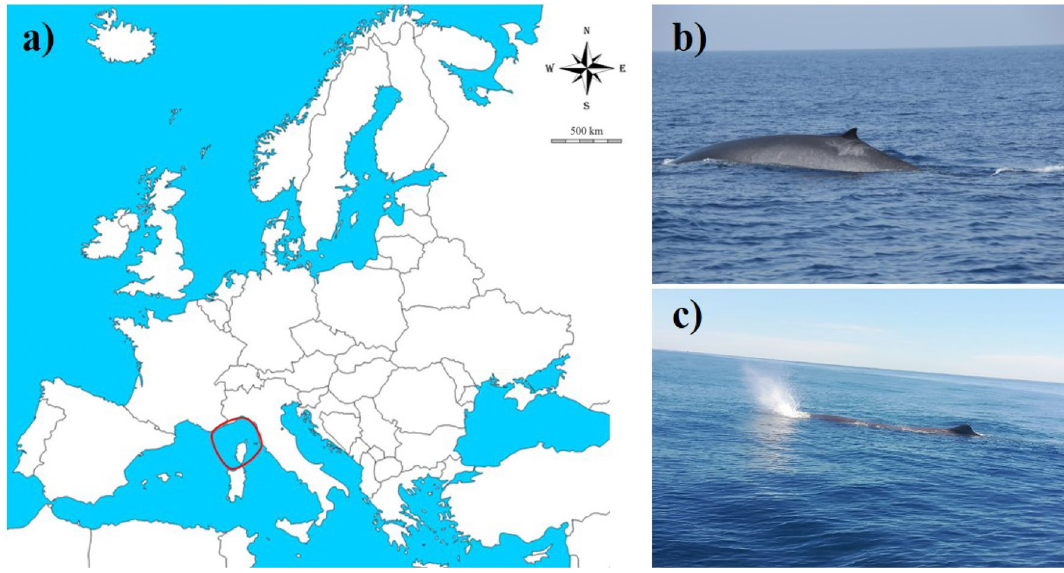
Figure 1. Fin and sperm whale faeces sampling. ( a ) Sampling area. The red circle indicates the Pelagos Sanctuary, Corsican-Ligurian Provencal Basin. The map was created using QGIS v. 2.14 software (http://www. qgis.org/it/site/). ( b,c ) Details about the fin whale and the sperm whale in the wild, respectively (photos by M.M. and Tethys Research Institute).